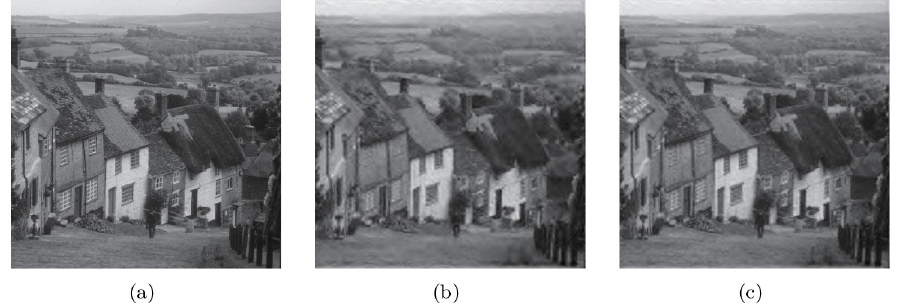
Fig 9. SPIHT based on a contourlet with 4,4,8,8 directions at each level; (a) Original image, (b) Reconstructed image after coding with 0.15 bpp, (c) Reconstructed image after coding with 0.3 bpp. It can be observed that (c) is clearer than (b) Reprinted from [40] under a CC BY license, with permission from IEEE publisher, original copyright